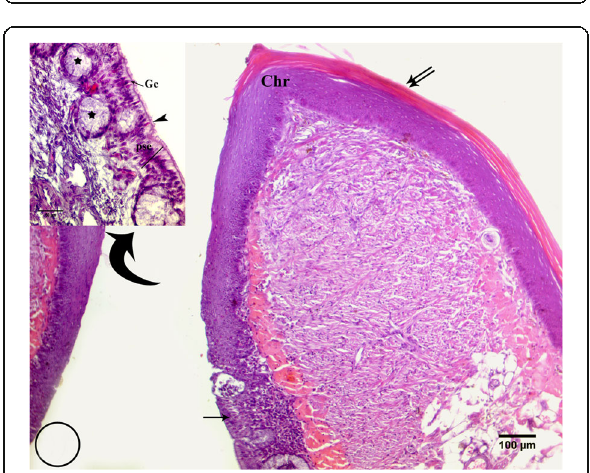
Fig. 9 High magnification of ventral surface of skull of hoopoe shows the maxillary process of the palatine bone (Map), maxillopalatine process (MP), vomer bone (arrow) is absent and replaced by a longitudinal ribbon of collagenous connective tissue, choana fossa (Fc), ventral crest (Vc), ventral fossa (Vf), Pterygoid (Pt), and parasphenoid (Sph). Upper right, photomicrograph of a transverse section of roof of hoopoe shows the collagenous connective tissue. (Masson ’ s Trichrome)